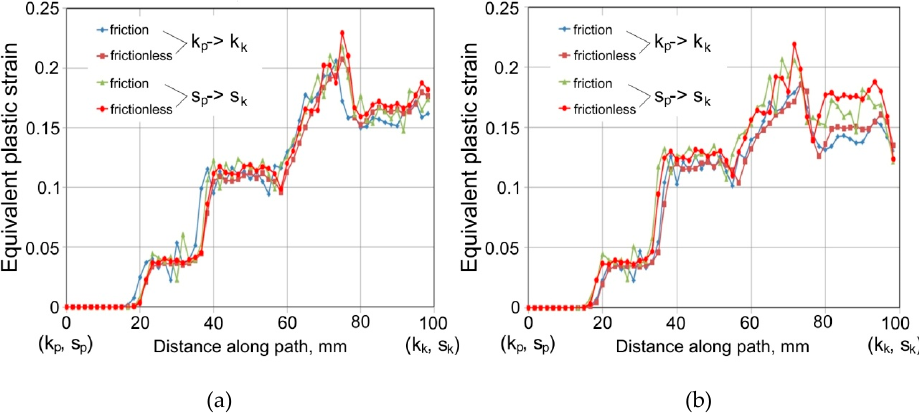
Figure 16. Distribution of EPS on ( a ) the internal and ( b ) external surface of specimen.